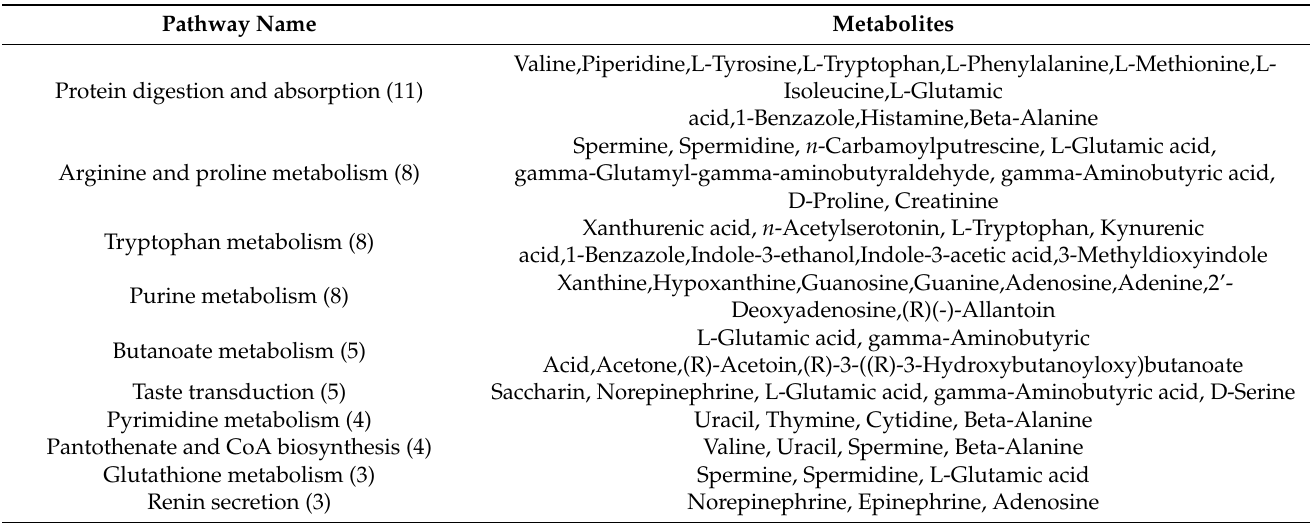
Table 9. Metabolic pathways and significant different metabolites that were enriched in the pathways of growing yaks fed a low- and high-protein diet.